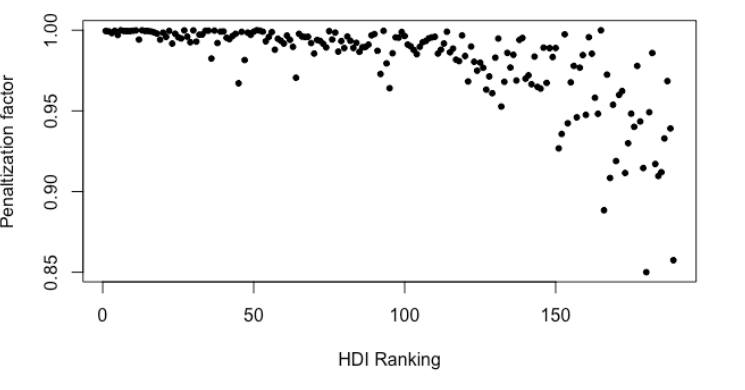
Figure 5. Penalization factor vs. HDI ranking.